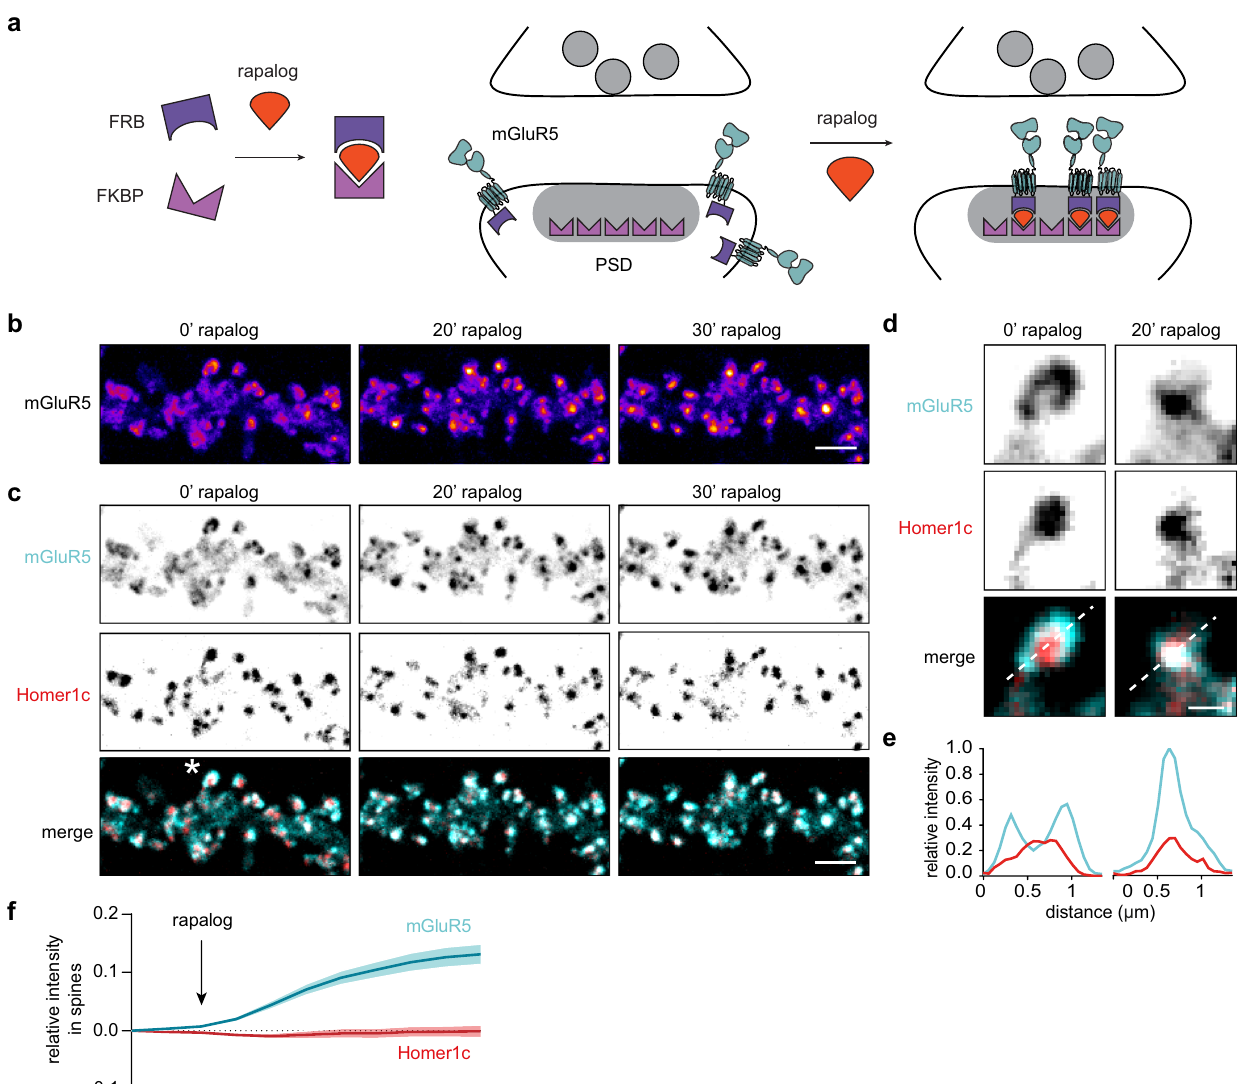
Fig.7|mGluR5isef fi cientlyrecruitedtothesynapseusingtheinducibleFKBP- rapalog-FRB heterodimerization system. a Schematic of the FKBP-rapalog-FRB heterodimerization system (left) and how this system is used to recruit mGluR5 to thePSD(right). b Live-celltime-lapseimagesofSEP-mGluR5-FRBbefore(0 ’ )and20 and 30min after rapalog application. The dendrites are color-coded for the fl uor- escenceintensityofSEP-mGluR5-FRB.Scalebar,2 µ m. c Live-celltime-lapseimages of the same dendrite as shown in b showing the relative localization SEP-mGluR5- FRB(cyan)and2xFKBP-Homer1c-mCherry(red)before(0 ’ )and20and30minafter